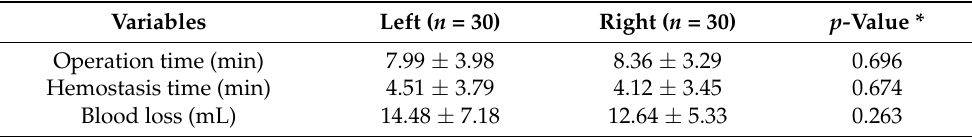
Table 5. Intergroup correlation of operation time, hemostasis time and blood loss by side in the adrenaline group. Variables Left ( n = 30) Right ( n = 30) p- Value * Operation time (min) 7.99 ±